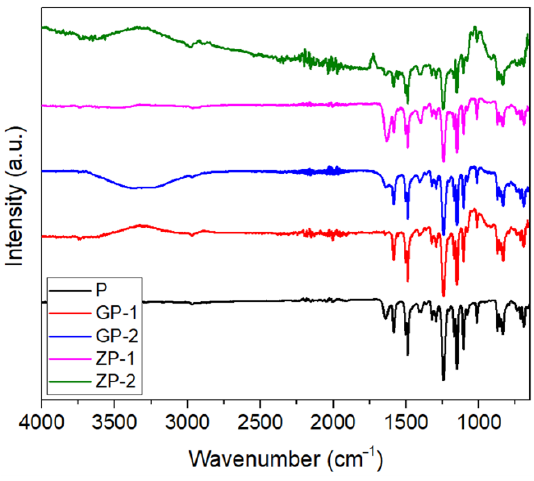
Figure 4. FTIR spectrum of fabricated membranes. Table 2. Major FTIR peaks and corresponding functional groups of fabricated